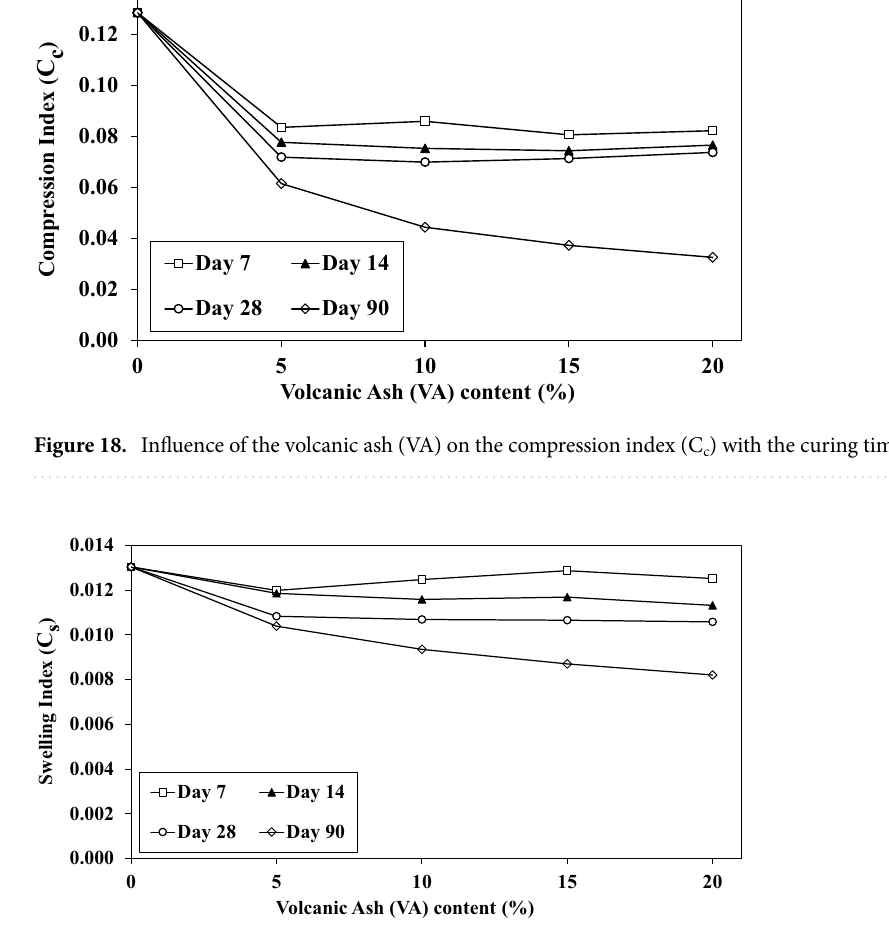
Figure 19. Influence of the volcanic ash (VA) content on the swelling index (C s ) for various curing time.